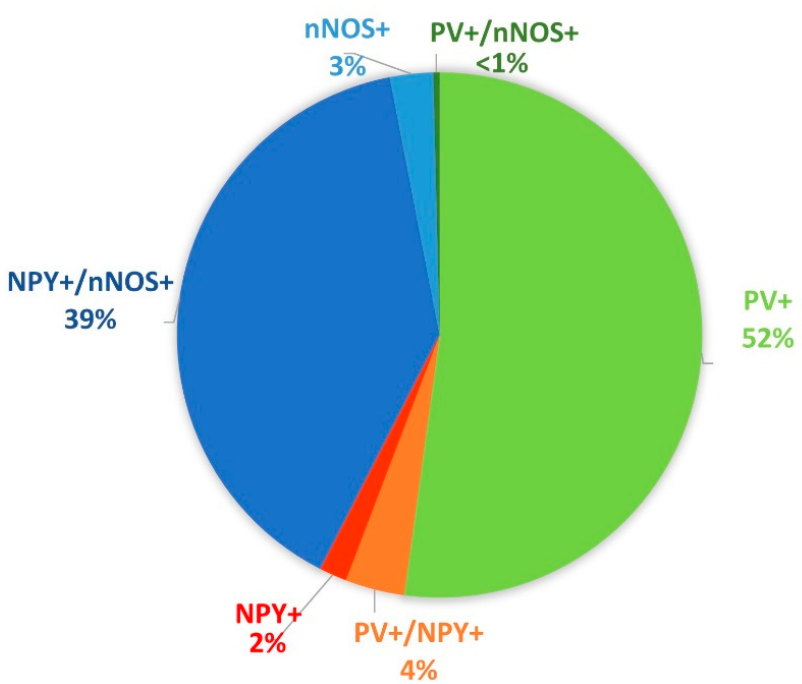
Figure 1. Proportional distribution of the different cell types based on the protein expression profile in the CA1 area of the control animals (including also the lacunosum moleculare layer). The largest populations were the parvalbumin (PV)+ cells (green) and neuropeptide Y (NPY)+/ neuronal nitric oxide synthase (nNOS)+ cells (blue). 3.1. PV+ Cells Cells in this group expressed parvalbumin (PV+) but were negative for NPY and nNOS (Figure 2). They were found in stratum oriens, pyramidale, and radiatum, but their majority was in the stratum oriens and pyramidale. PV+ cell density did not show signif- icant differences among the groups (F(3,20) = 1.441, p = 0.26) (Figure 3).